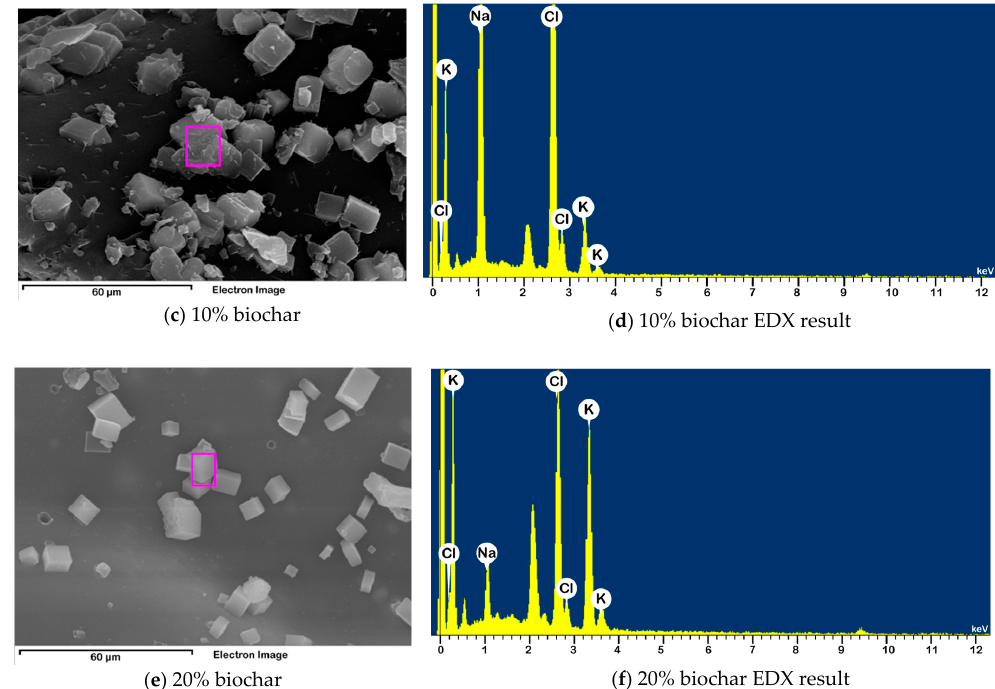
Figure 3. ( a – f ) NaCl crystal shape deformations and EDX results for biochar samples with different